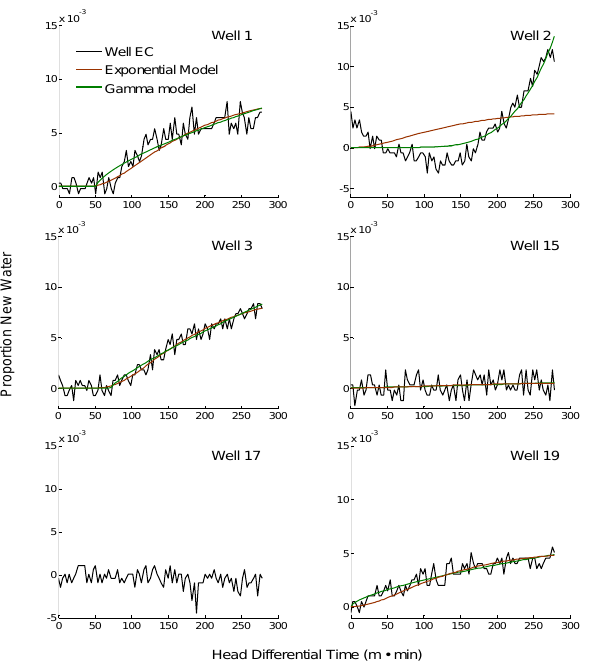
Fig. 8. Optimized models of EC truncated at the end of head differ- ential time for salt-added test. EC response in wells 1 and 3 was not modeled. Well 2, which was modeled with an inverse input function, is displayed on a larger-scale axis because of larger-scale